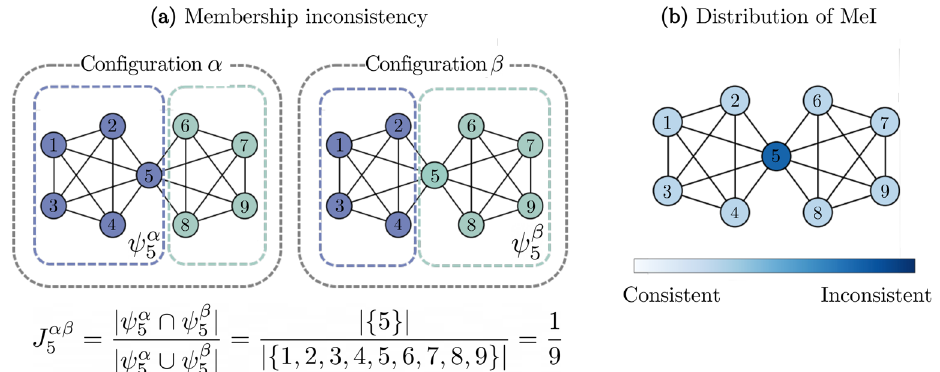
Figure 2. An illustrative example of the membership inconsistency analysis. ( a ) A representation of the two configurations α and β of the example network. From each configuration, the set of nodes that belong to the β same community with node 5 is given by ψ α 5 and ψ 5 respectively. ( b ) An illustration of the distribution of (cid:31) of the network. The colors of the nodes indicate the relative strengths of MeI. A node with higher (cid:31) is colored in darker